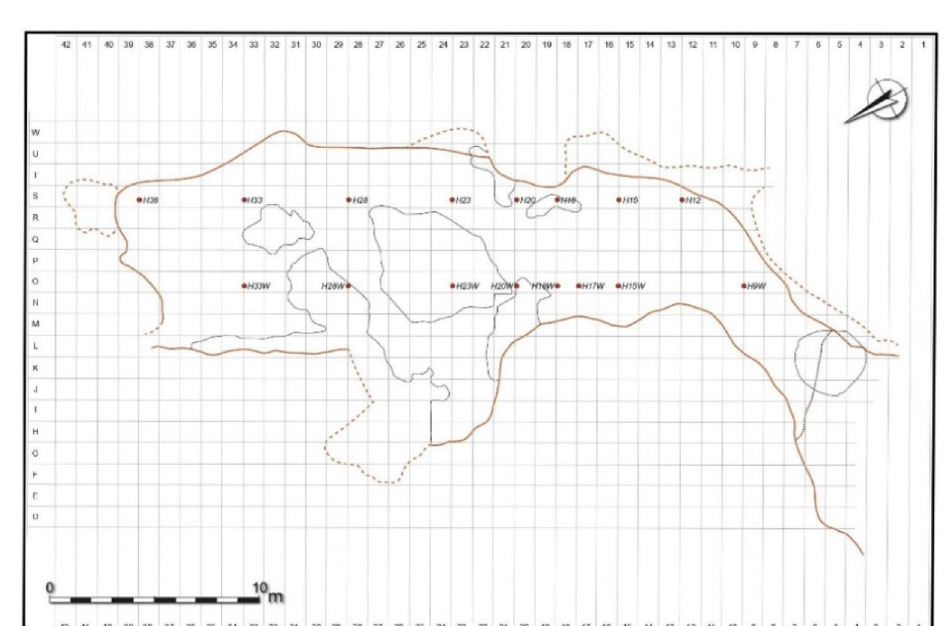
Figure 4. Lazaret Cave map with the simulated hypothetical hearth locations, based on ( 69 , p. 40). (Courtesy of Prof. Henry de